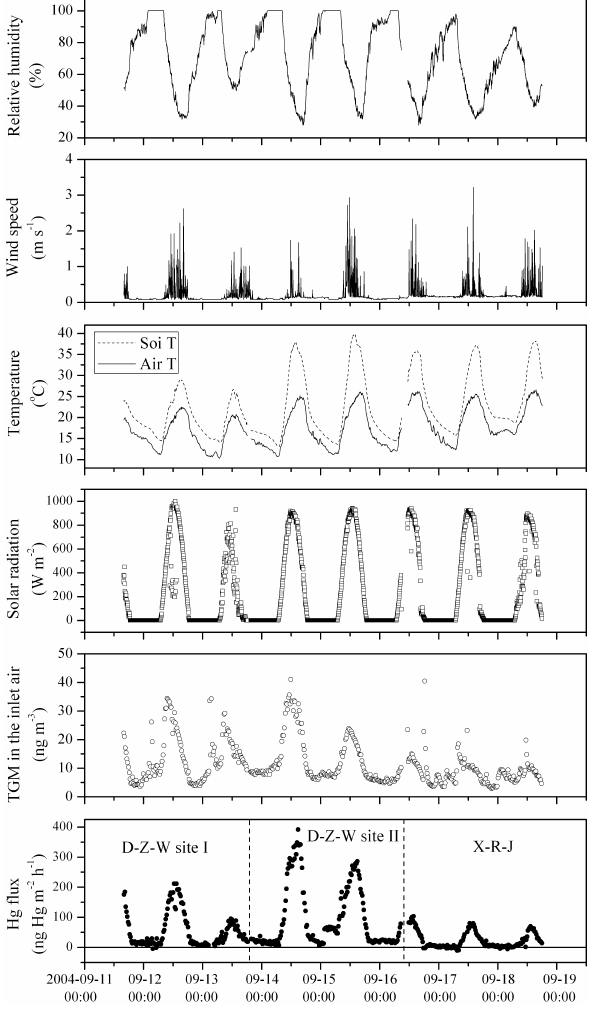
Fig. 5. Mercury surface-air fluxes at soil covering area of D-Z-W and grassed area of X-R-J landfill: the effect of vegetation on the mercury emission